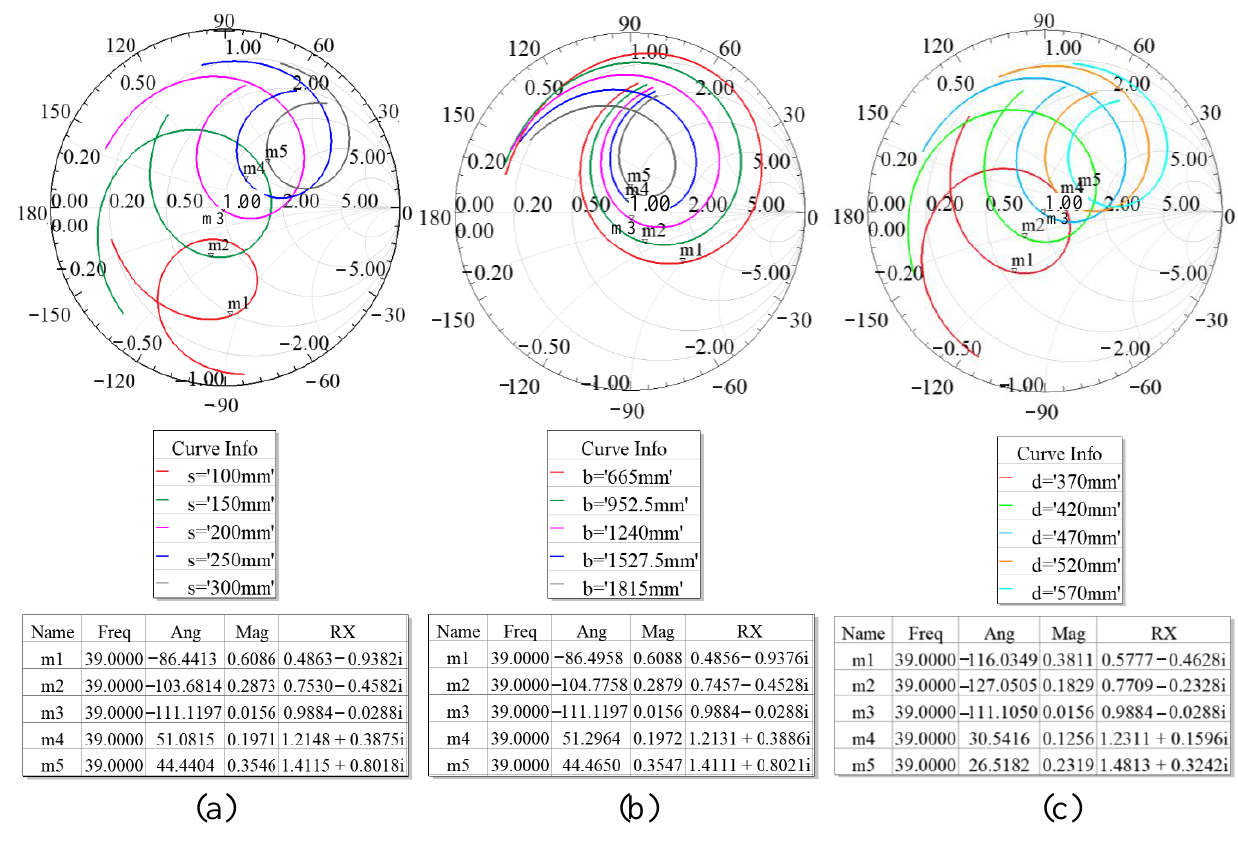
Figure 1. The simulation model of the designed turnstile antenna.